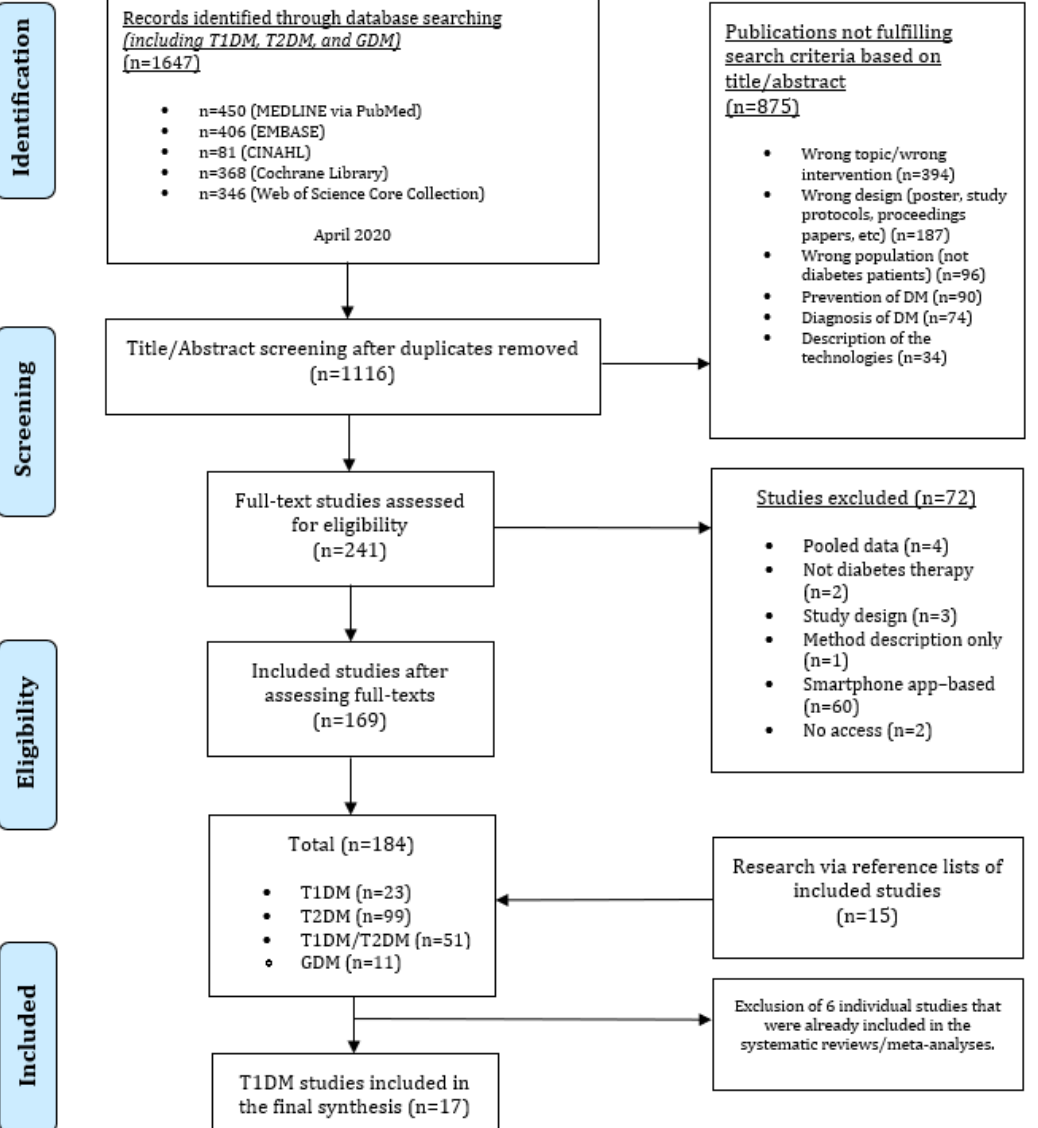
Figure 1. PRISMA flowchart of the procedure for the search and selection of suitable publications (adapted from Moher et al [15]). GDM: